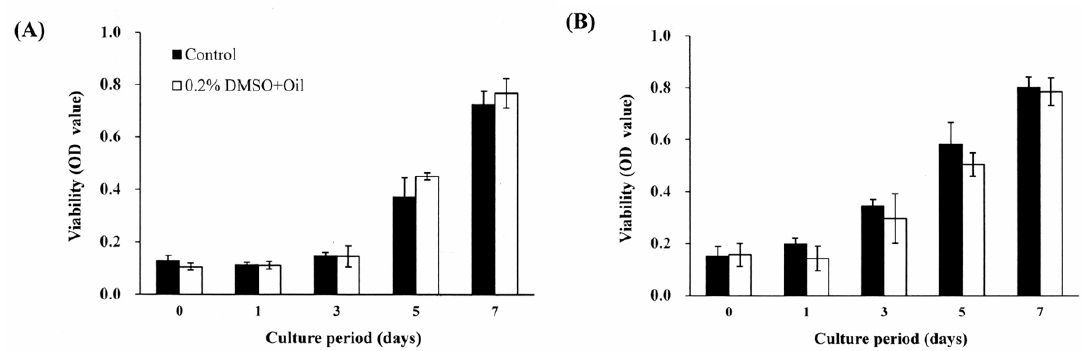
Figure 3. Effects of S. mukorossi seed oil on viability of DPSCs seeded with cell densities of: ( A ) 2 × 10 4 cells/mL and ( B ) 5 × 10 4 cells/mL. For both seeding densities, similar tendencies are noted when comparing the experimental group and control group. In particular, no significant difference in the